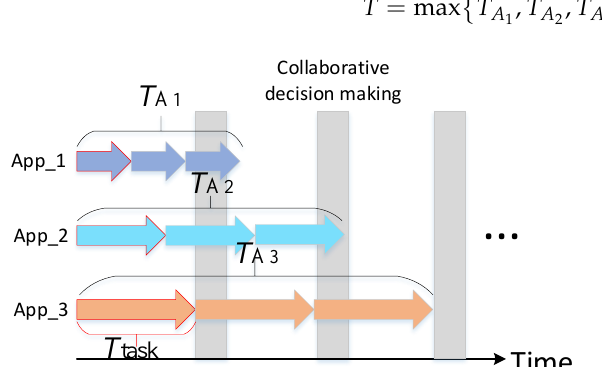
Figure 3. Schematic of tasks execution on the embedded edge